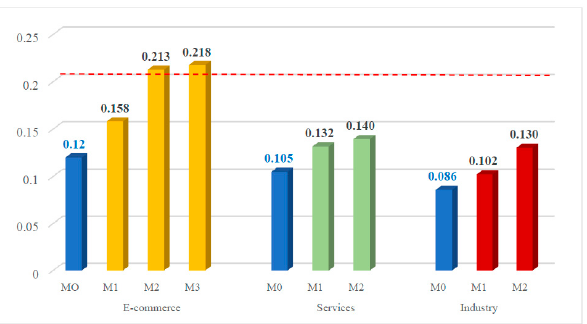
Figure 2. Average values of Spc indicator for each indicator before and after Spc implementation. (Note: M0 represents the moment before implementation (blue color) and from M1 to M2; M3 rep- resents the moment after implementation: yellow for e-commerce, green for services and red for industry). As major differences between employees in the same sector in terms of average labor productivity have been observed since the M0 moment of the research, in Figure 3, we represent the distribution and structure of the Spc indicator‘s ranges, highlighting the ef- ficiency and performance of e-commerce, as the range of values is much more varied but also better positioned compared to the services and the industry sectors.